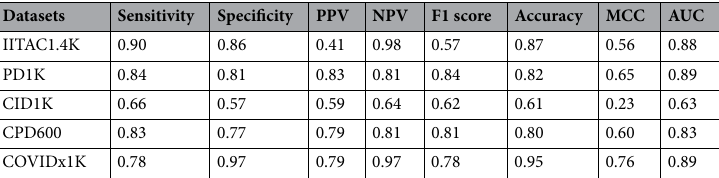
Table 1. Performance metrics of CovBaseAI model on independent testing datasets. PPV positive predictive value, NPV negative predictive value, MCC Matthews correlation coefficient, PD1K pneumonia detector, CID1K COVID infection detector, CPD600 COVID pneumonia